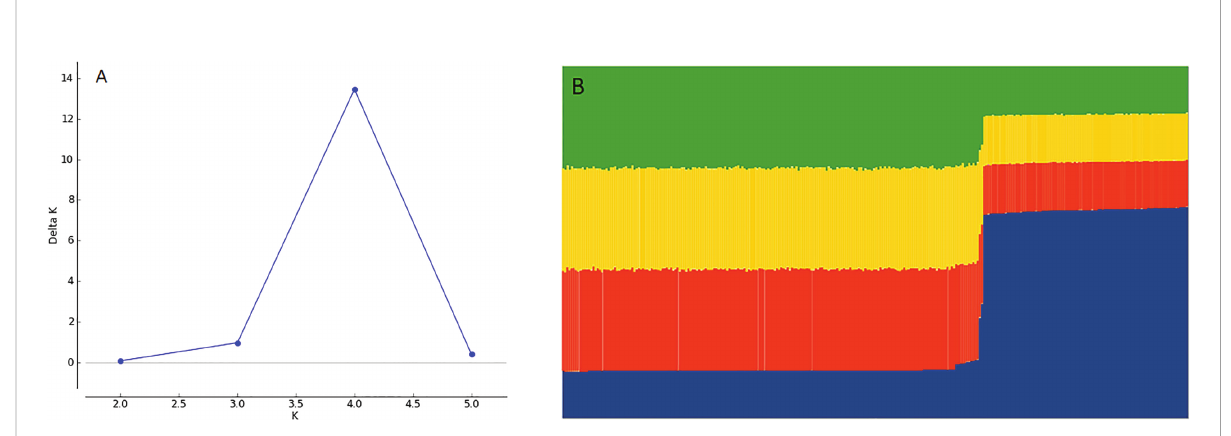
FIGURE 5 (A) Plot for Delta K at different K values. Higher value at K = 4 with Delta K = 14. (B) Bar plot of STRUCTURE assuming K = 4 subpopulations showing 2 clusters of